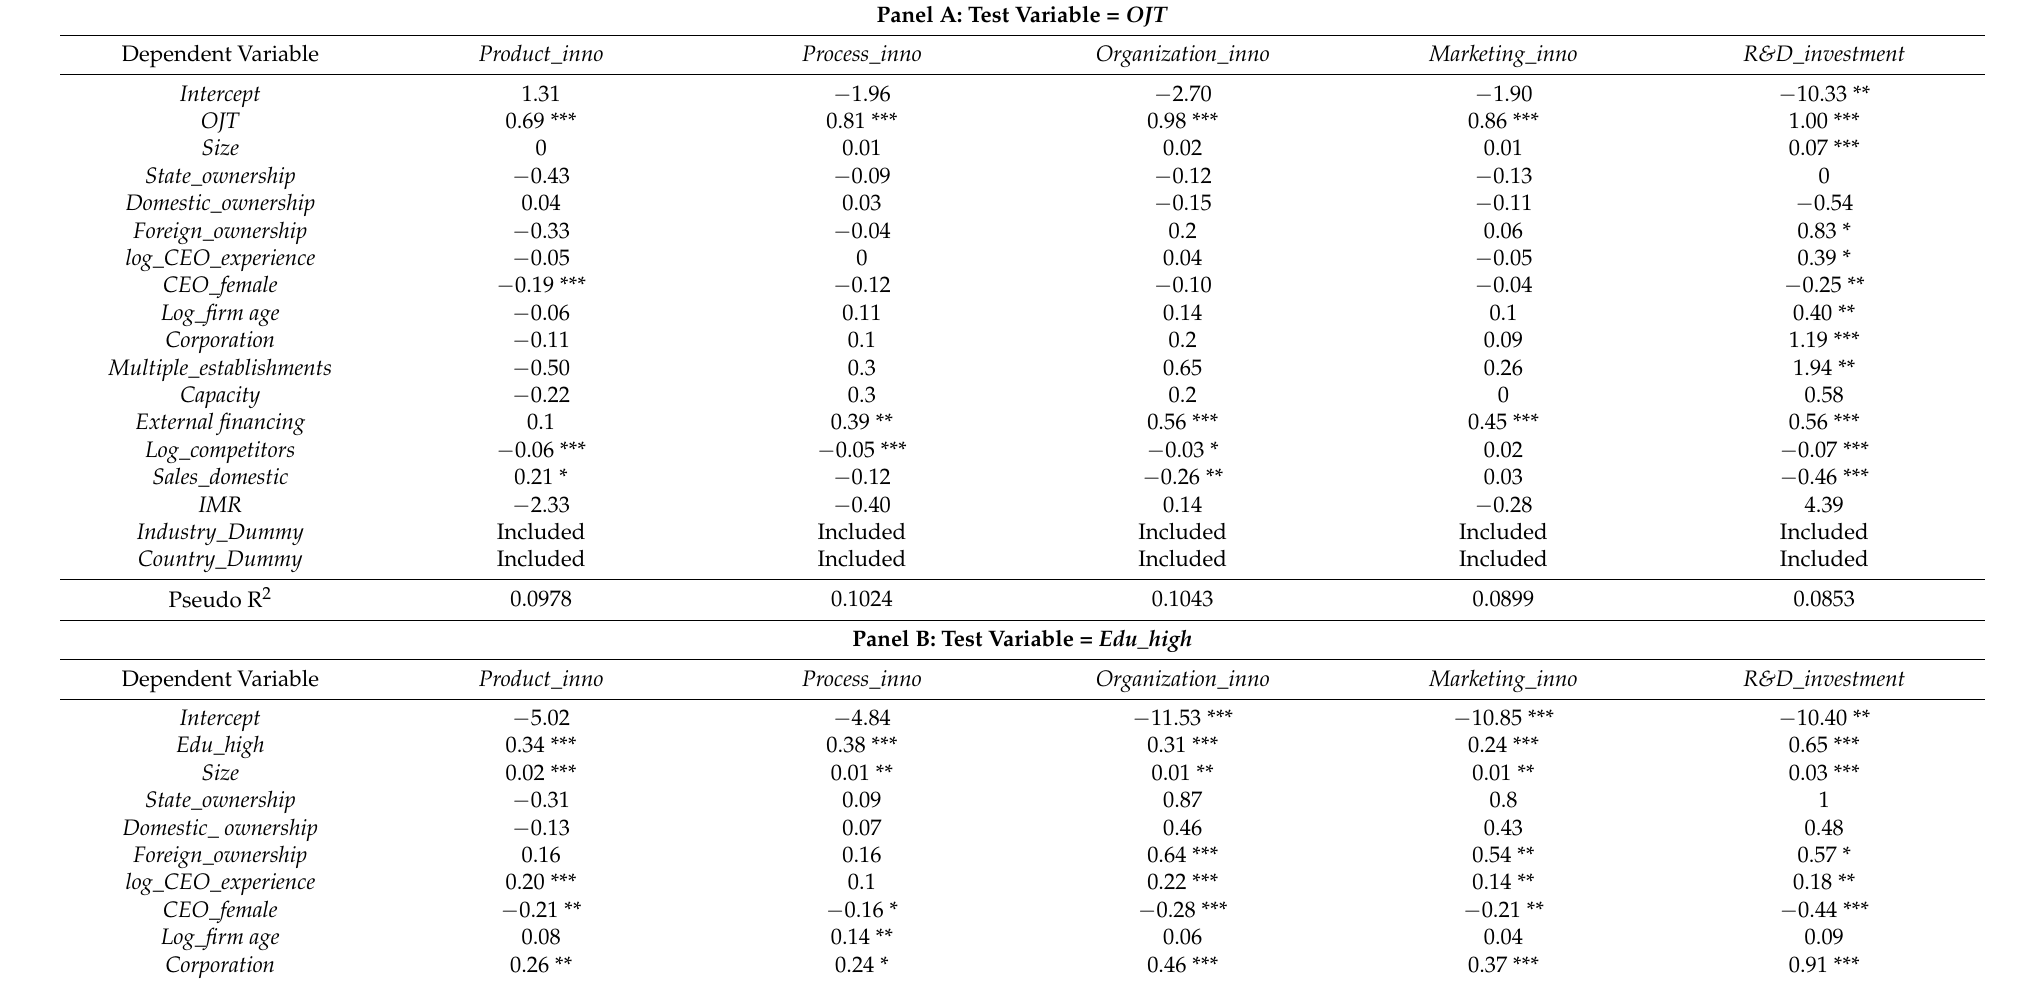
Table 6. Main regression results (total observations =